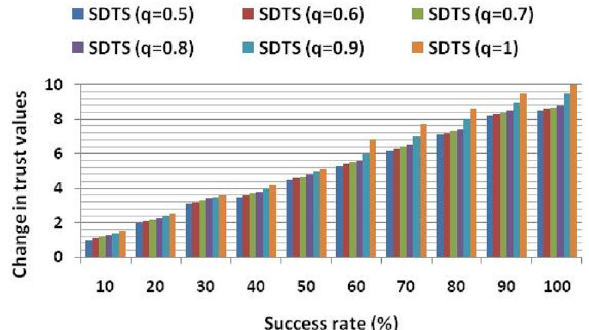
Figure 4. Change in trust values at different values of q.